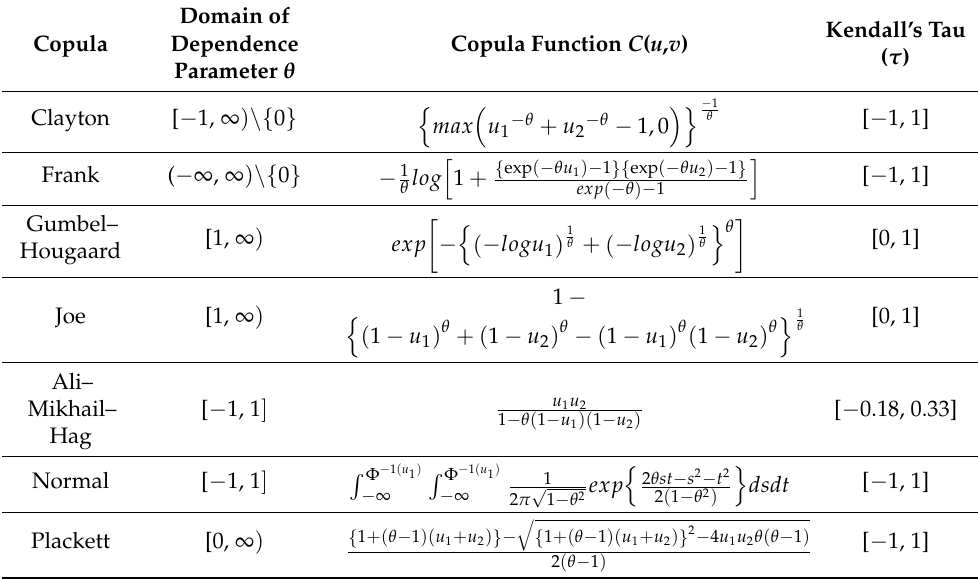
Table 1. Copula functions used in this